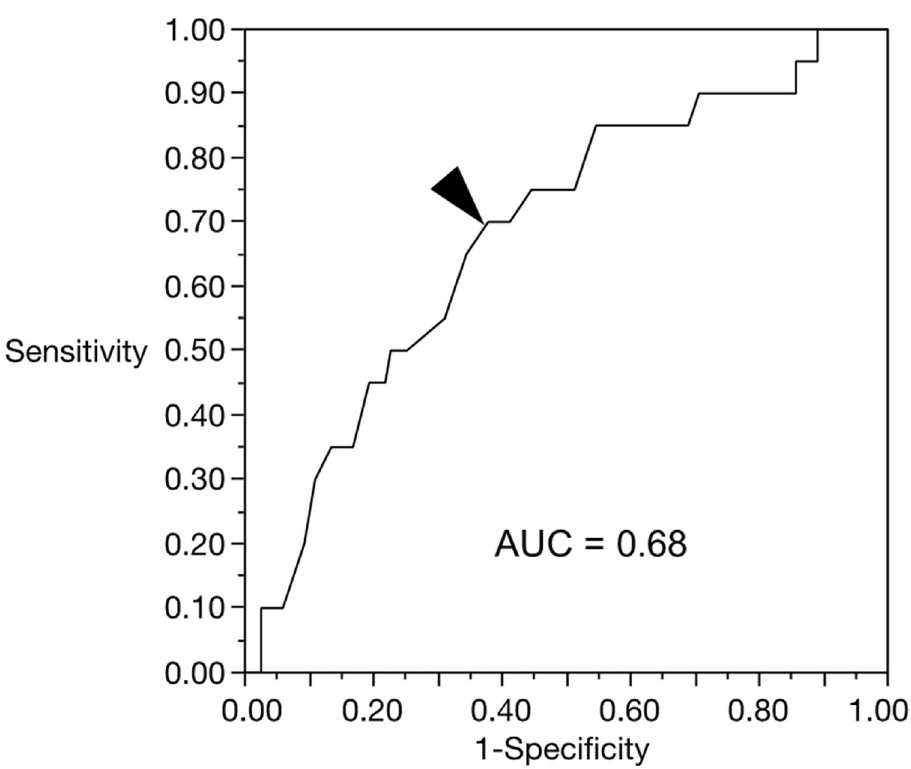
Figure 2. ROC curve for the exercise frequency as a predictor of drop-out (AUC = 0.68). The triangle on curve shows optimal cut-off point (25), corresponding with the maximum sum of sensitivity (70.0%) and specificity (62.2%). ROC = receiver operating characteristic, AUC = area under the